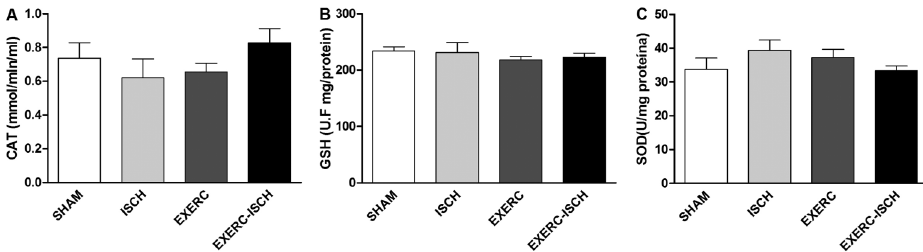
Figure 5. Transient global ischemia-reperfusion and physical exercise did not alter antioxidant markers. A , catalase activity (CAT), B , glutathione (GSH) levels, and C , superoxide dismutase activity (SOD) in the four groups. Data are reported as means ± SD.